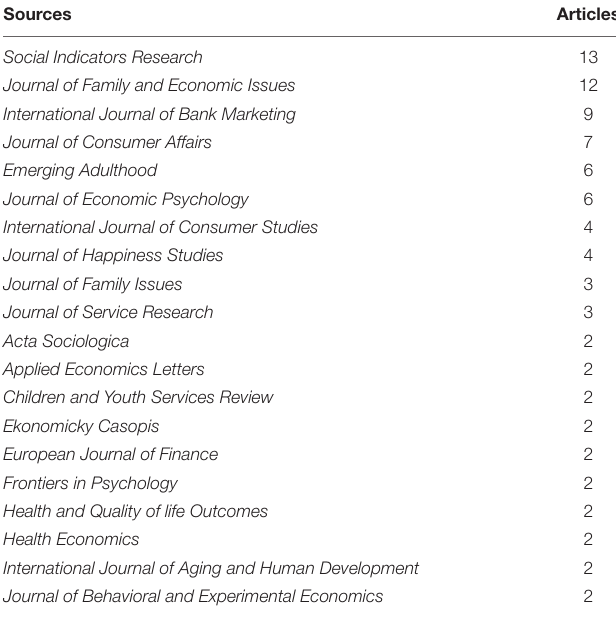
TABLE 2 | List of top 20